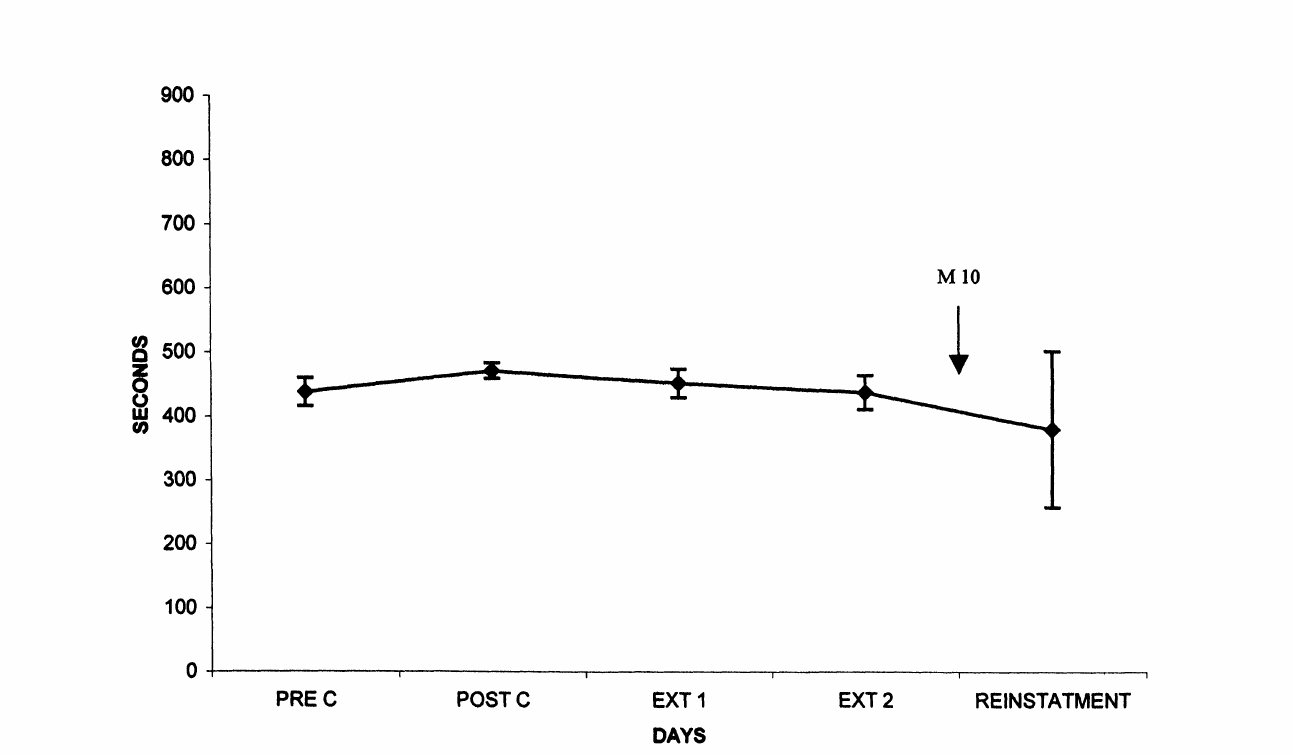
Fig. 3" (C) Lack of effect of a priming dose of 10 mg/kg of" morphine in animals without CPP. Animals were conditioned with 2 mg/kg of morphine and do not acquire CPP, as is reflected by the lack of significant difference in the time spent in drug paired compartment between pre-conditioning (PRE C) and post- conditioning (POST C). Afterwards, mice underwent three consecutive extinction sessions (EXT 1, EXT 2 and EXT 3) and received a priming dose of 10 mg/kg of morphine (MI0) and 30 min after were tested for their preference (REINSTATEMENT). No significant differences in the time spent in drug-paired compartment in pre-conditioning vs. post-conditioning sessions or reinstatement test were